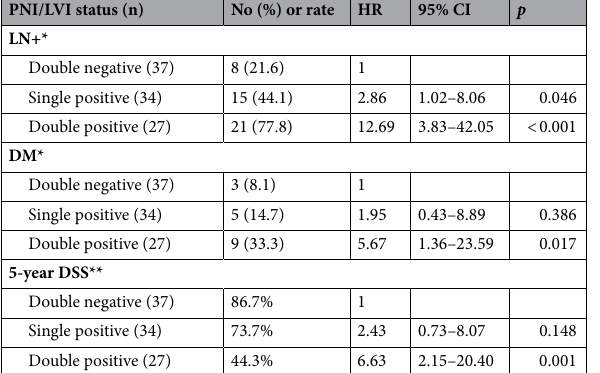
Table 5. LN+, DM and 5-year DSS according to combined PNI and LVI status. PNI perineural invasion, LVI lymphovascular invasion, LN + neck metastasis, DM distant metastasis, DSS disease-specific survival. *Binary logistic regression. **Cox proportional hazards